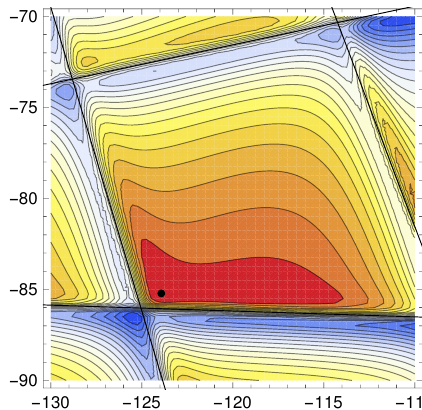
Figure 9. A close-up of the plot shown in Fig. 8. The maximum is shown with a black dot. The colors are scaled to the minimum and maximum in the graphed region, namely 5960 to 9535 log- likelihood units. The light paths which cross the region are also shown.